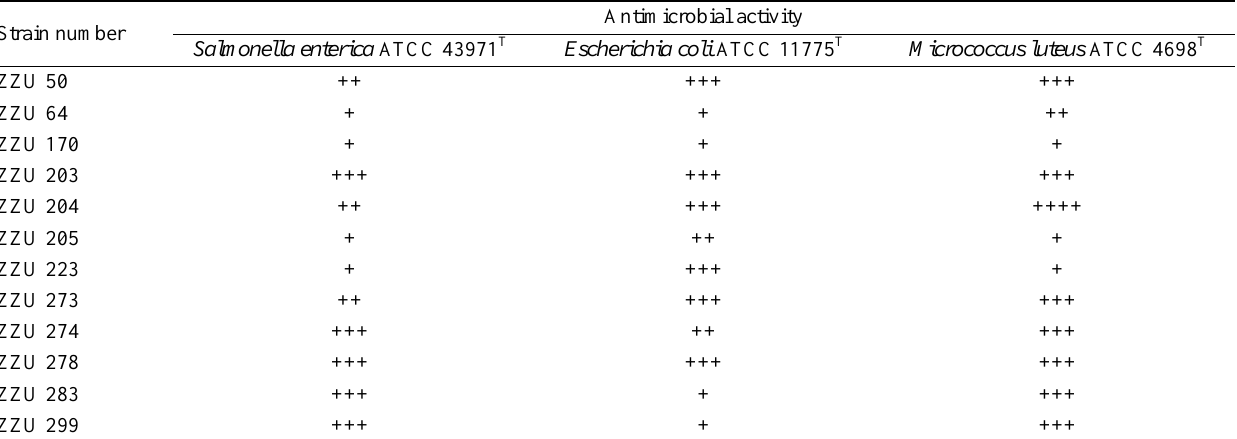
Table 4. Antimicrobial activity of the representative strains Strain number